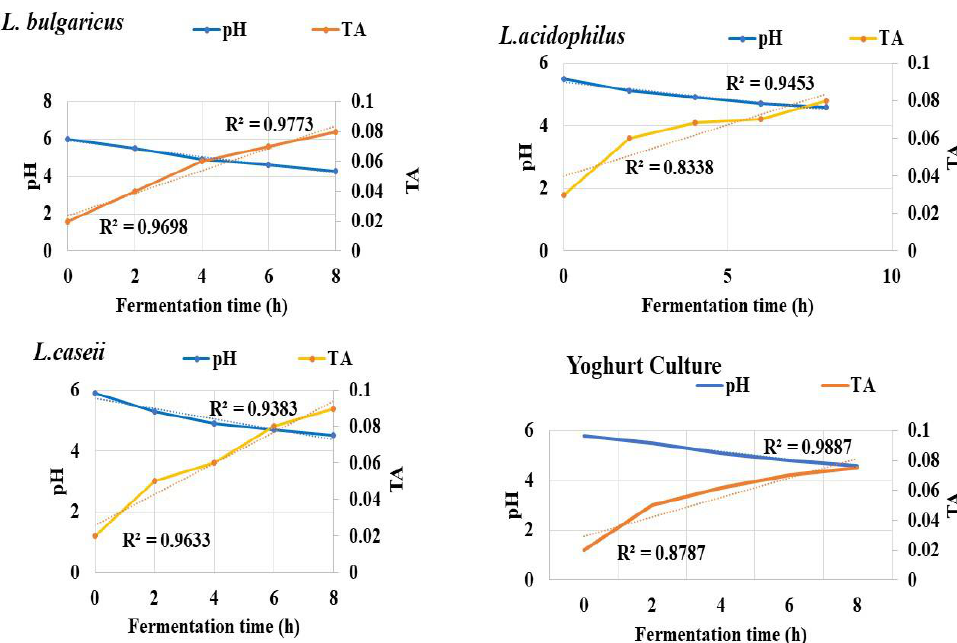
Figure 4. Chemical properties (pH and TA) of broken rice milk and the three LAB strains against commercial yogurt culture (control) during eight hours of fermentation, incubated at 37 °C.